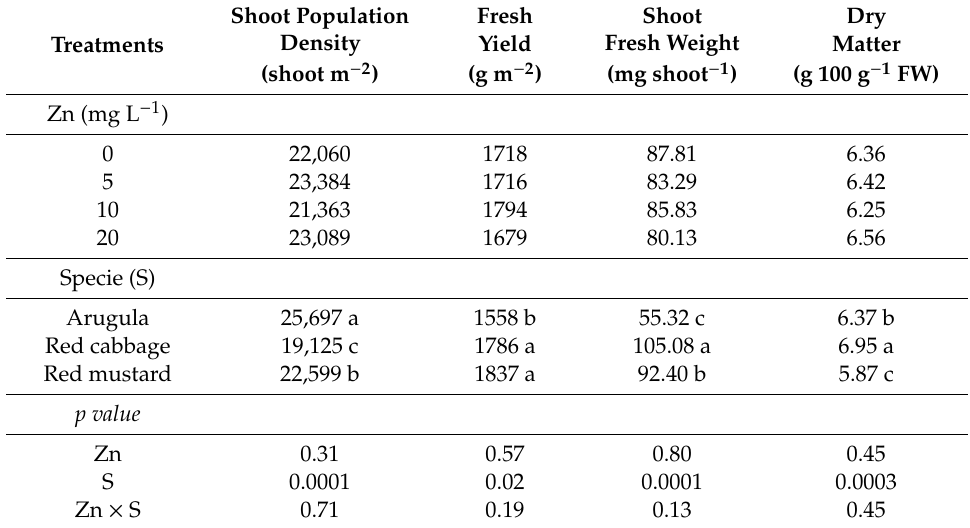
Table 1. Nutrient solution zinc (Zn) level effects on shoot population density, fresh yield, mean single shoot fresh weight, and dry matter accumulation of arugula, red cabbage, and red mustard microgreens 1